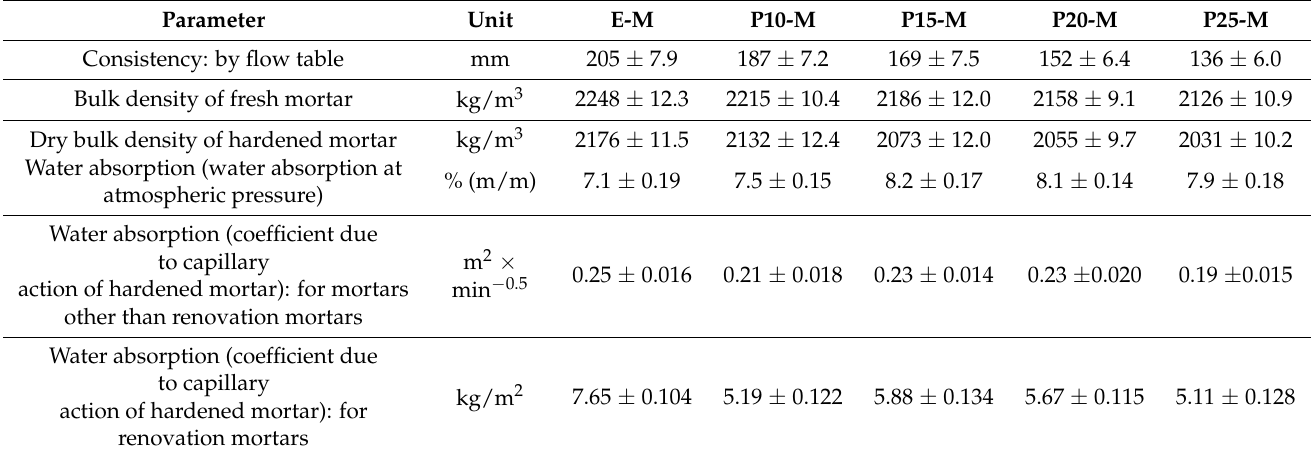
Table 4. Physical properties of fresh and hardened mortar.